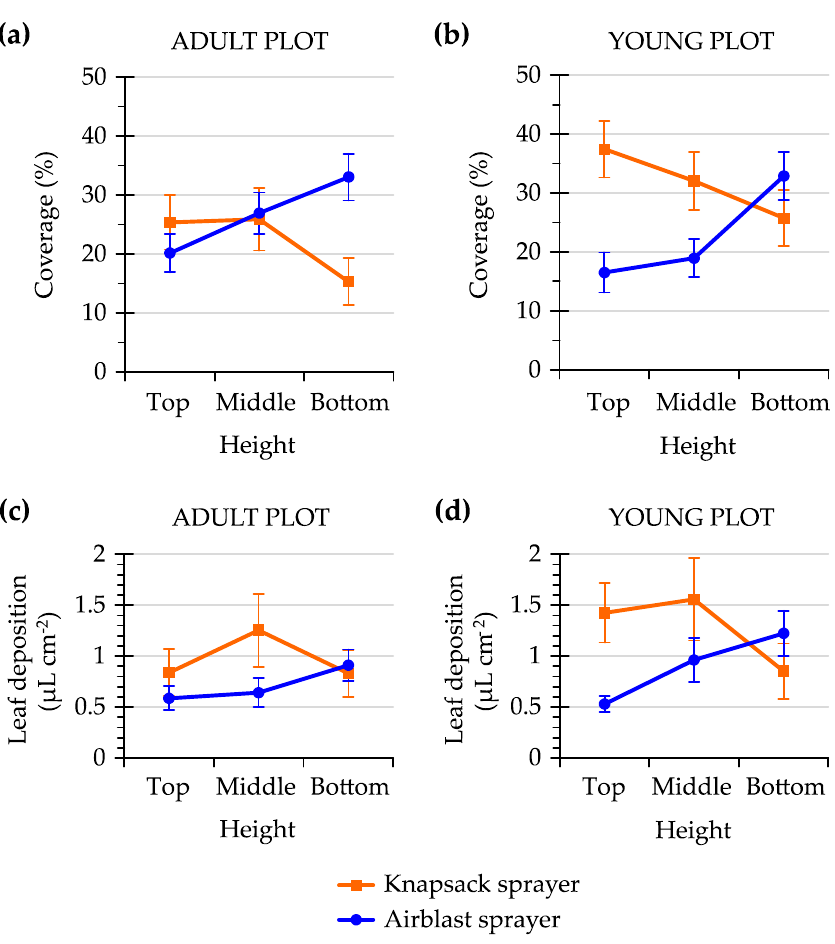
Figure 11. “Sprayer × Height” interaction for coverage (%) (mean (s.e.)) for the ( a ) adult and ( b ) young plots, and for leaf deposition ( μ L cm − 2 ) (mean (s.e.)) for the ( c ) adult and ( d ) young plots.